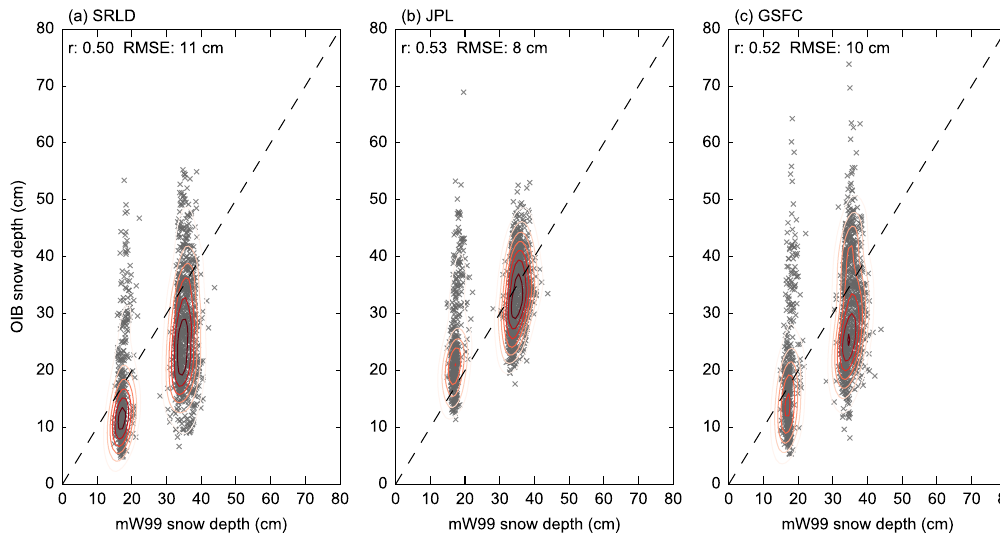
Figure 16. As in Fig. 15 but showing comparisons of modified Warren snow depths (mW99) against the OIB snow depths.